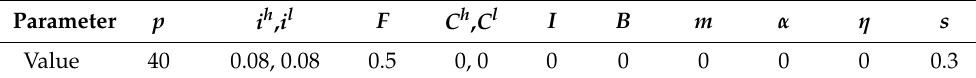
Table 8. Initial parameter values (inactive lending platform).